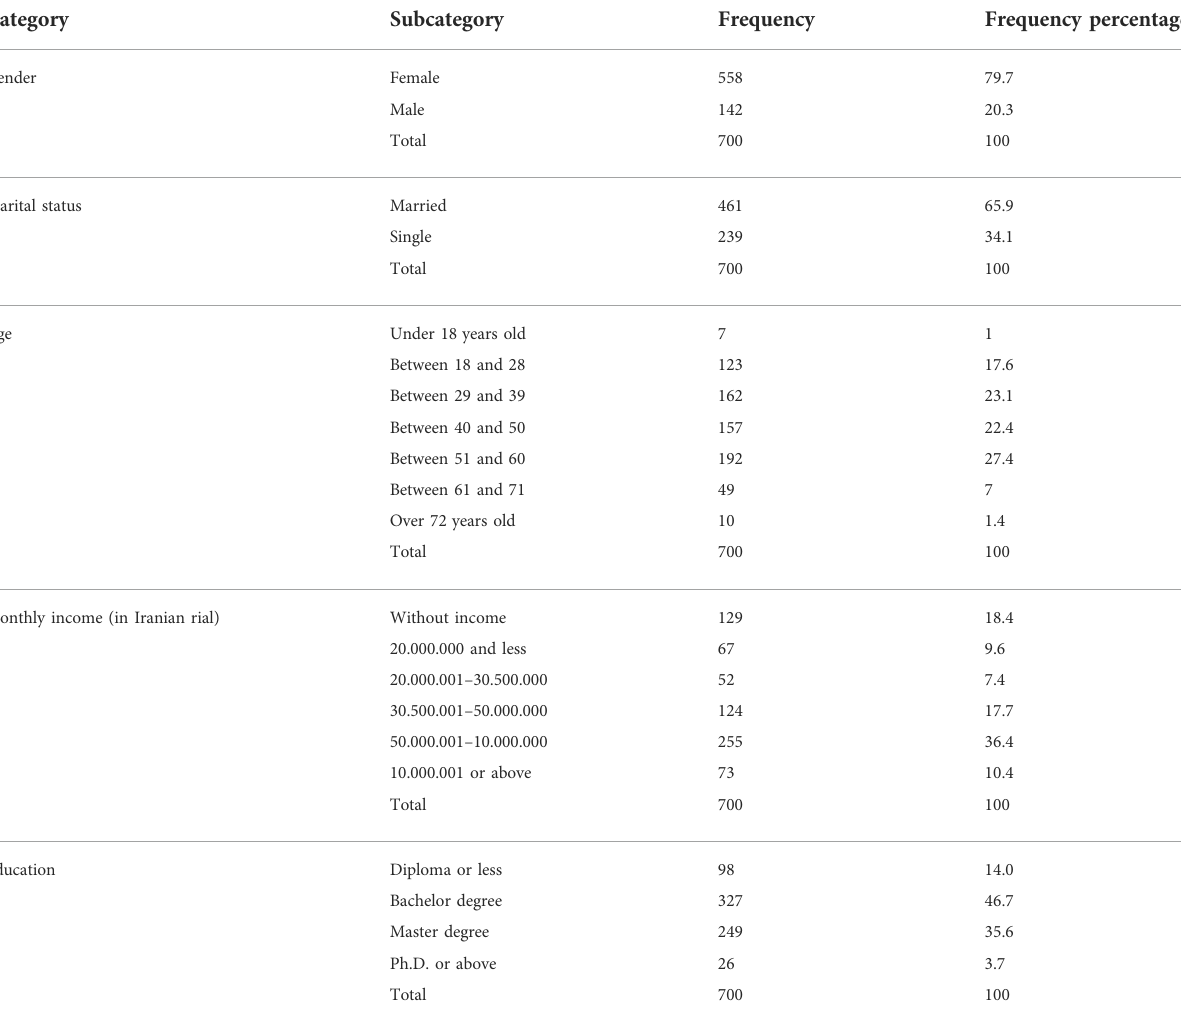
TABLE 3 Demographic variables.